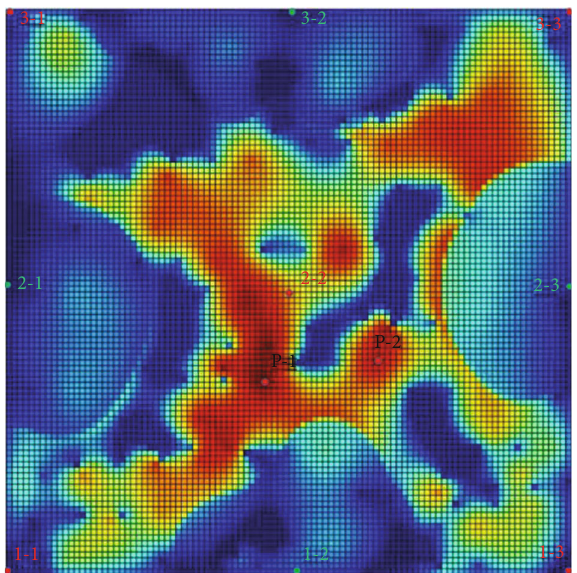
Figure 10: Schematic diagram of pattern in fi lling in scheme 1: red circle — production well; green circle — injection well.